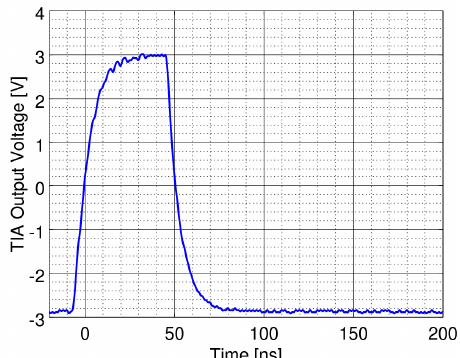
Figure 7. The optical pulse generated by the SOA and retrieved by the TIA amplifier after an attenuation stage to avoid TIA saturation. The pulse duration at 90% of the maximum intensity is below 40 ns, while the full width at half-maximum (FWHM) is 50 ns. The rise and fall times are ~13 ns.